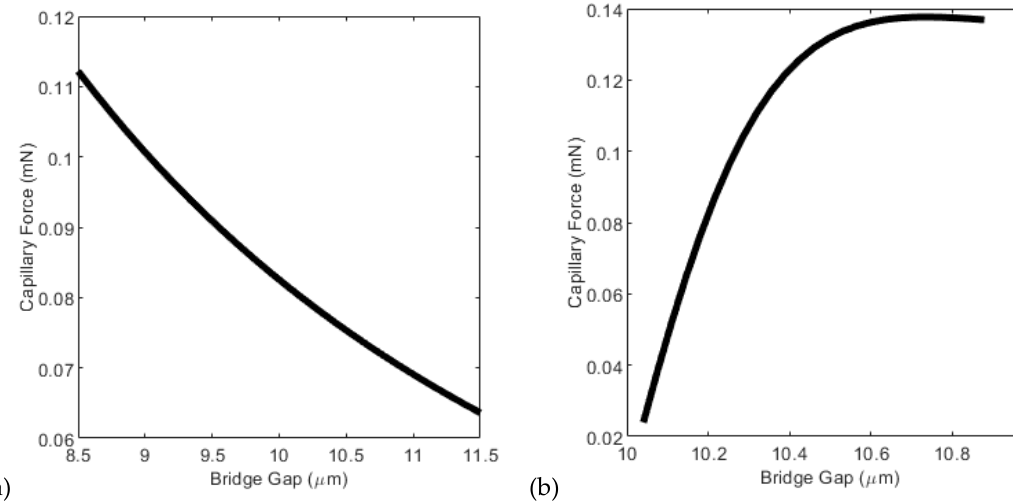
Figure A2. How the capillary force varies with the gap as given by Equation 2 for the geometry shown in Figure A1. (a) The contact angle is constant; (b) the contact angle varies.